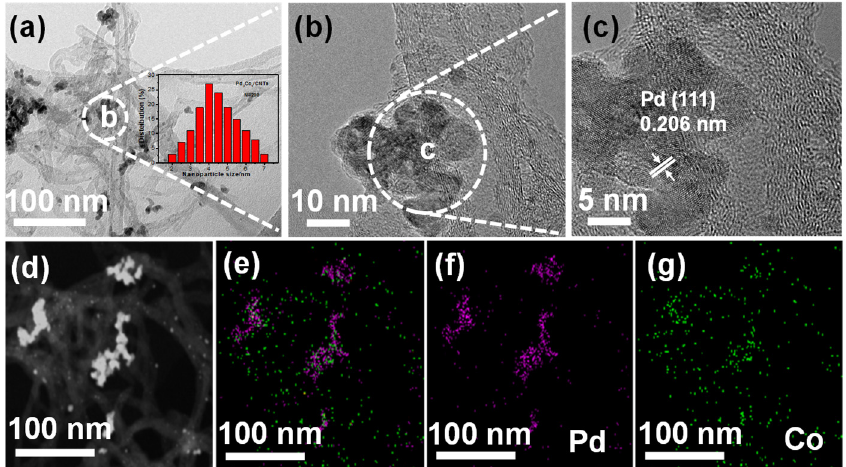
Figure 2. TEM and HRTEM images (the corresponding particle size distribution); HAADF-STEM elements.